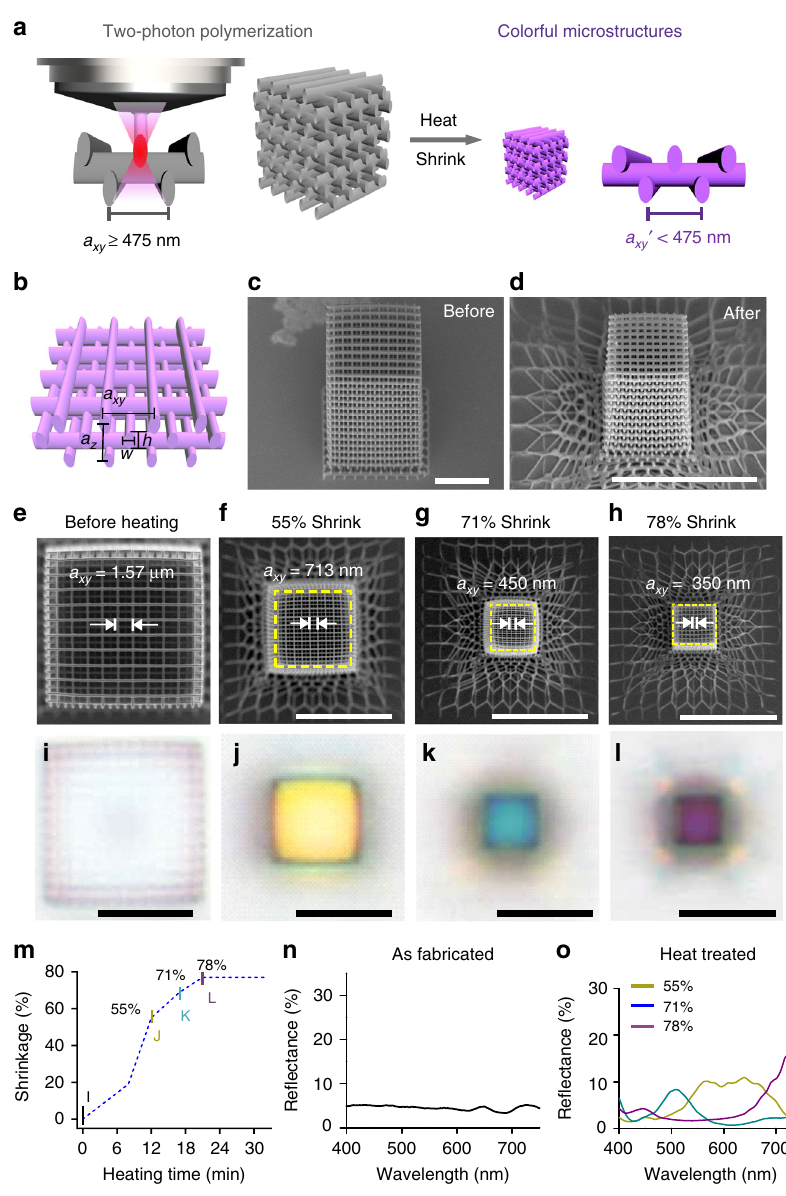
Fig. 1 Heat shrinking induced colors of 3D-printed woodpile photonic crystals. a Schematic of the fabrication process. Left: woodpile photonic crystal written in commercial IP-Dip resist by two-photon polymerization at dimensions well above the resolution limit of the printer to prevent structures from collapsing. Right: after heat treatment, the dimensions of the photonic crystal are reduced below the resolution limit of the printer, and colors are generated. The colors change with different degrees of shrinkage. b Schematic showing one axial unit of the woodpile structure. a xy and a z denote the lateral and axial lattice constants, respectively. Tilted-view scanning electron micrographs (SEM) of a representative woodpile photonic crystal ( c ) before and ( d ) after heating. SEM images and corresponding bright fi eld re fl ection-mode optical micrographs of the woodpile photonic crystal before heating ( e , i ) and with shrinkages of 55% ( f , j ), 71% ( g , k ), and 78% ( h , l ). m Shrinkage of the woodpile photonic crystal heated at ~450 °C as a function of heating duration. Re fl ectance spectra of the woodpile photonic crystal n before heating and o after heating with 55%, 71%, and 78% shrinkage. Scale bars represent 10 μ initial w of 330 nm and h of 1.1 μ m. Figure 1e – h, i – l is SEMs and substrate. The three bottom units are analogous to “ rafts ” in fused corresponding optical micrographs of the structures after 12, 17, and 21 min of heating at 450 °C, clearly showing a lateral shrinkage of 55% ( a xy = 713 nm), 71% ( a xy = 450 nm), and 78% ( a xy = 350 nm), respectively. The rod width w decreased to ~100 nm after 21 min of heating (Fig. 1h). After heat shrinkage, the bottom three repeat units turned into an intricate net-like mesh due to the adhesion of the bottom-most layer to the substrate (Fig. 1d). However, the top nine repeating units were observed to be uniform after shrinking as they are suf fi ciently far from the